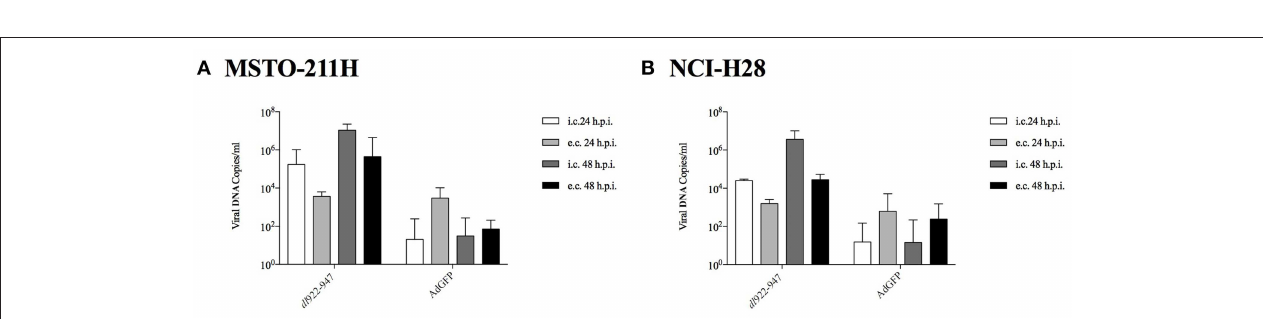
FIGURE 1 | Cytotoxic effect of dl 922-947 in MPM cell lines. (A) Dose-response curves obtained through SRB assay assessing cell viability in MPM cell lines 5 days after treatment with dl 922-947 at the indicated concentrations. The results are reported as the means ± s.d. of at least 2 independent experiments, each conducted in triplicate, and expressed as percentages of cell viability calculated with respect to the control cells treated with DMSO alone. (B) Table reporting the dl 922-947 IC50 values, determined through SRB assay upon 5 days of treatment as calculated by GraphPad Prism 7.